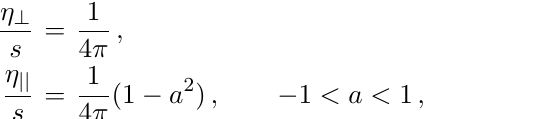
Figure 1 . Ratio of shear viscosities and entropy density in a spinning black hole. (cid:17) are both shown as function of the rotation parameter a . The corresponding shear viscosity ratios for the spinning planar limit black brane are coincident with those